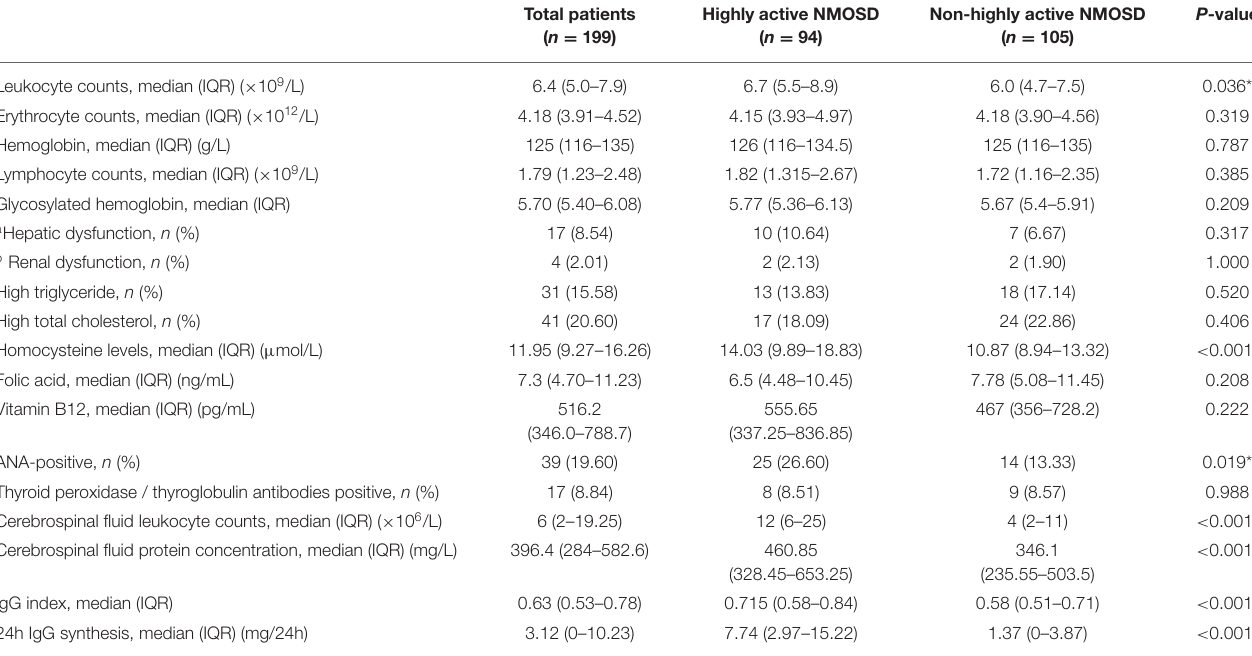
TABLE 2 | Comparison of laboratory tests between patients with highly active NMOSD and non-highly active NMOSD patients.